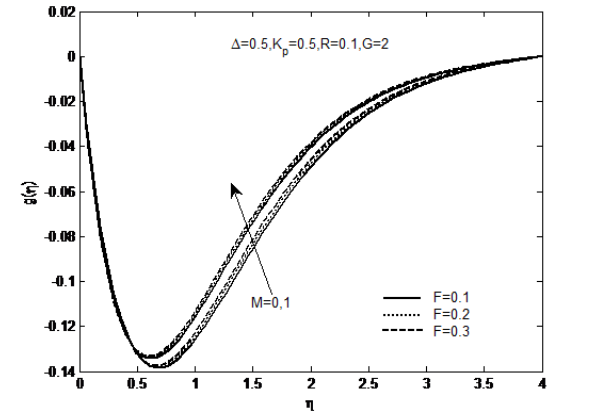
Fig. 7: Angular velocity profile for different values of M and F